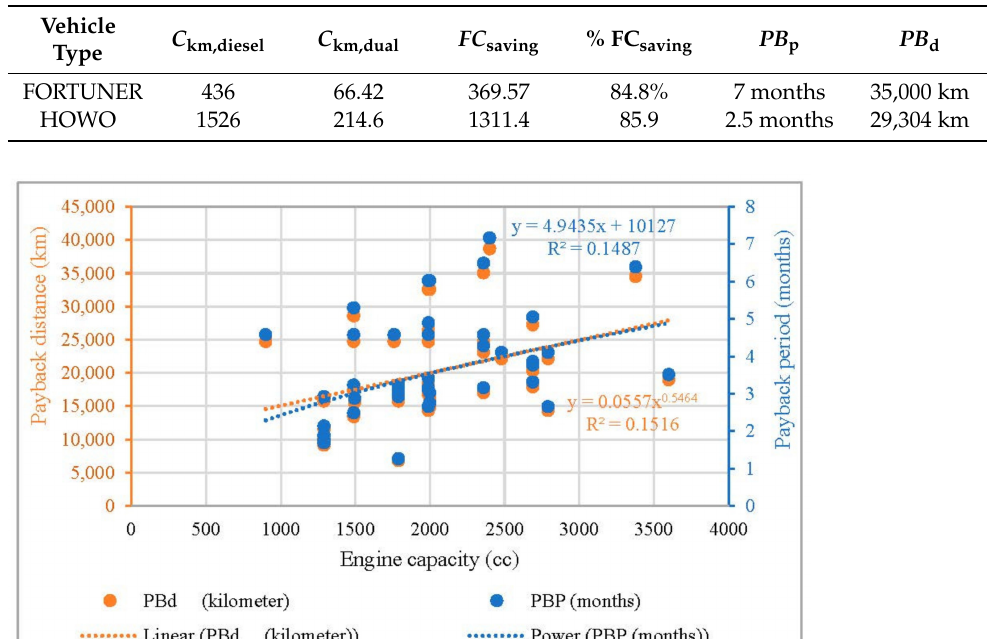
Figure 5. The comparison of fuel cost per kilometer and fuel cost saving for gasoline vehicles with different engine capacities. Table 5. Assessment of the dual fuel NGVs’ performance.